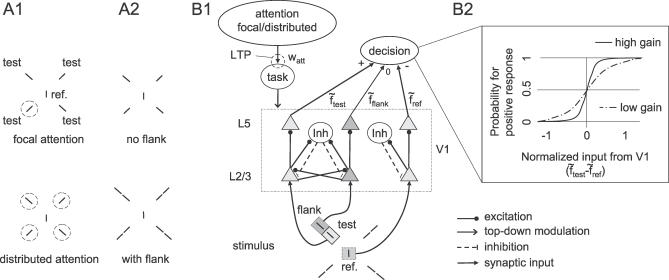
Brightness Discrimination Task and Model(A) The stimulus in the brightness discrimination task consists of four test bars surrounding a reference bar, with one of the four test bars deviating in brightness from the others. The task is to report whether this deviating test bar is brighter than the reference bar or not (see [1,18]). Preceding cues may either focus attention to that deviating test bar or distribute attention across all four test bars (A1). To study contextual interactions in both attentional states, the test stimuli were presented with or without a collinear flanking bar (A2).(B1) The model V1 consists of layer 2/3 (L2/3) pyramidal neurons which are recurrently connected and receive feedforward sensory input. The L2/3 neurons feed through corresponding layer 5 (L5) pyramidal neurons to a decision network in a higher cortical area. The two L2/3 neurons responsive to the nearby flank- and test-bar, respectively, are recurrently connected and drive a common inhibitory neuron feeding back to them. The spatially displaced reference bar (ref) drives a separate L2/3 neuron with its own recurrent inhibition. Top-down input depolarizes the inhibitory neurons through depressing synapses (as explained in Figure 2) and additionally increases the gain of L2/3 and L5 pyramidal neurons. This attentional drive is weak for distributed and strong for focal attention. Learning consists in further strengthening the top-down synapses (watt) from the attentional centers to the task neuron, modeled by Hebbian LTP.(B2) The decision population is stochastically activated (1 or 0), with an activation probability being a sigmoidal function of the difference between the V1 output encoding the test and reference bar, fx̃test − fx̃ref. The top-down gain increase steepens this probabilistic decision function (solid line: task neuron active; dash-dot line: not active).